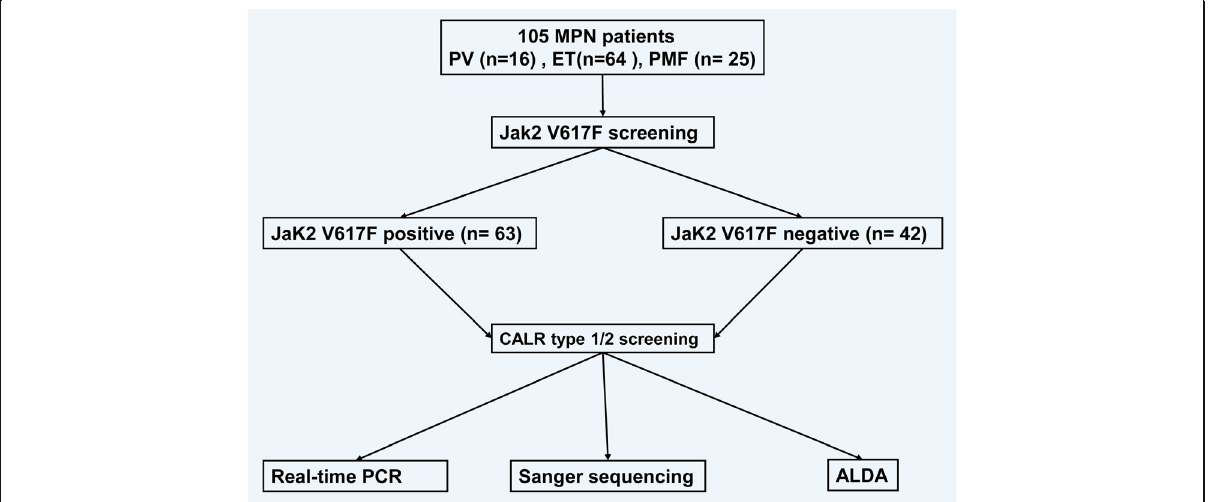
Fig. 1 Study design. All recruited MPN patients were initially screened for BCR-ABL transcripts to differentiate BCR-ABL positive or negative MPN patients using real time PCR. All 105 MPN patients BCR-ABL transcripts negative were subjected to an ARMS-PCR method to screen for the presence or absence of the Jak2 V617F mutation. Irrespective of the presence or absence of wildtype or mutant, all 105 MPN patients were subjected to an in-house developed PCR based protocol (ALDA -amplicon length differentiation assay) for simultaneous detection of CALR type-1 and CALR type-2 mutations. Furthermore the ALDA assay was comparatively evaluated with Sanger sequencing and other available real-time PCR methodologies as described by Zinke et. al